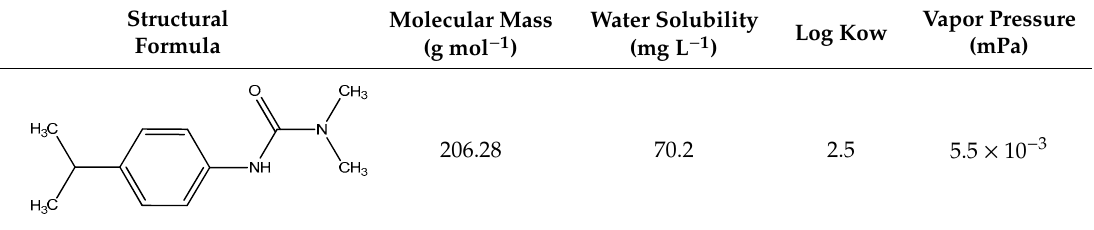
Table 1. Main physico-chemical properties of isoproturon [24].